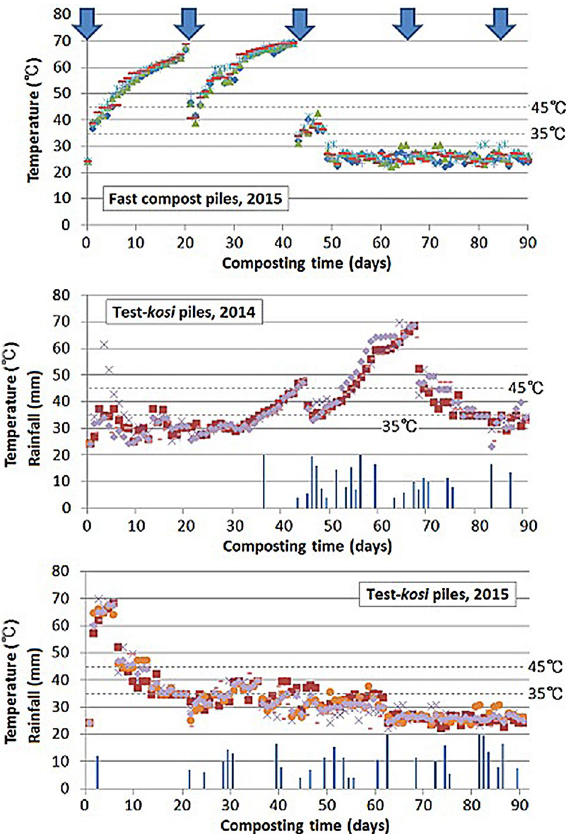
Figure 3. Temperature changes in the test- kosi and fast compost piles during the composting process. Arrows indicate watering and pile